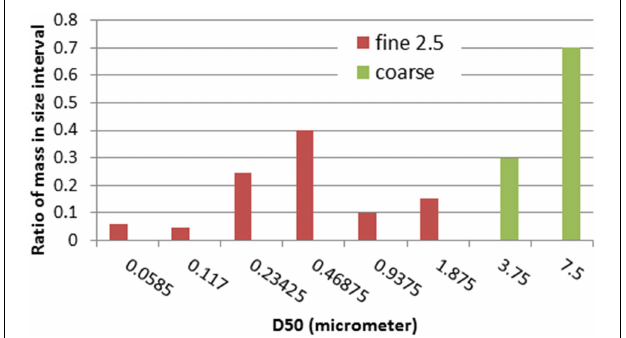
FIGURE 3 | Proportion of the aerosol mass distributed at each size interval considered in the MOSAIC approach applied to the